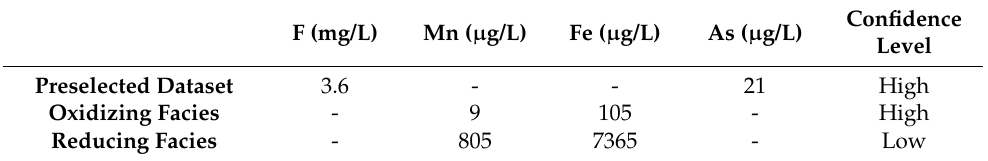
Table 3. Calculated NBLs and associated confidence